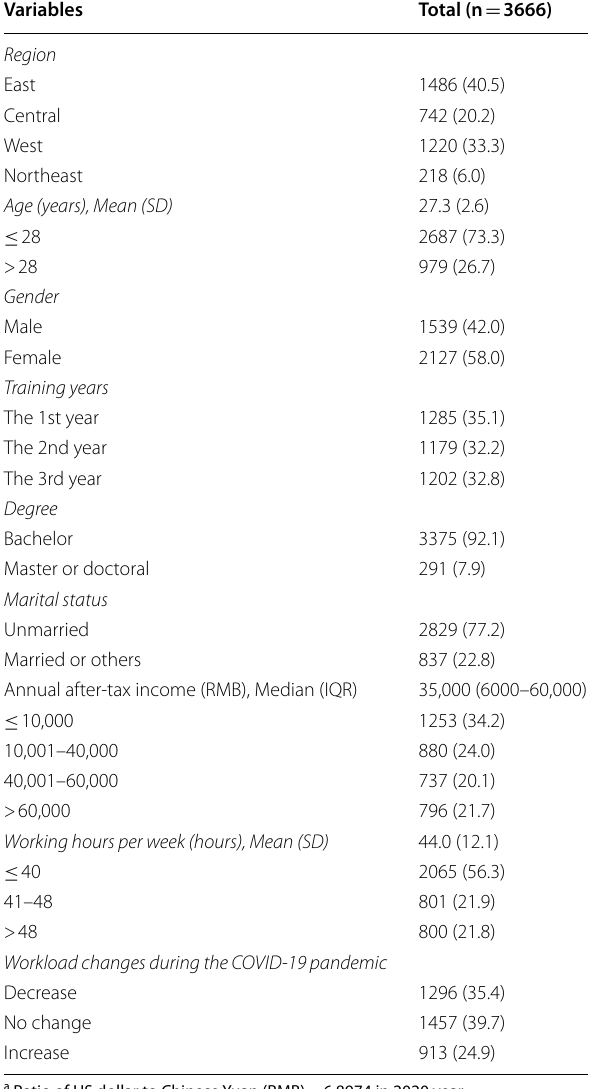
Table 1 Characteristics of surveyed participants in